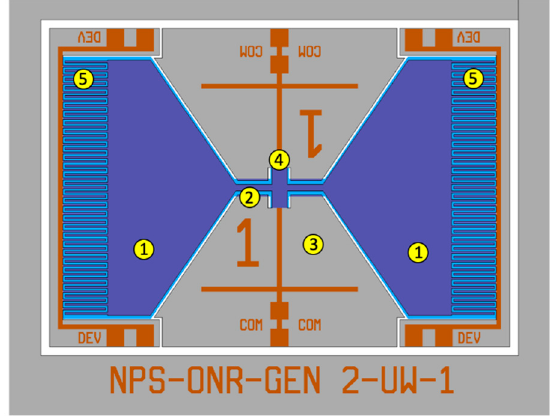
Figure 8. Layout diagram of the acoustic directional MEMS showing two free-standing wings (1) interconnected by a bridge (2), anchored to the substrate (3) by a torsional leg (4), and the interdigitated comb finger capacitors (5) at the edge of the wings.